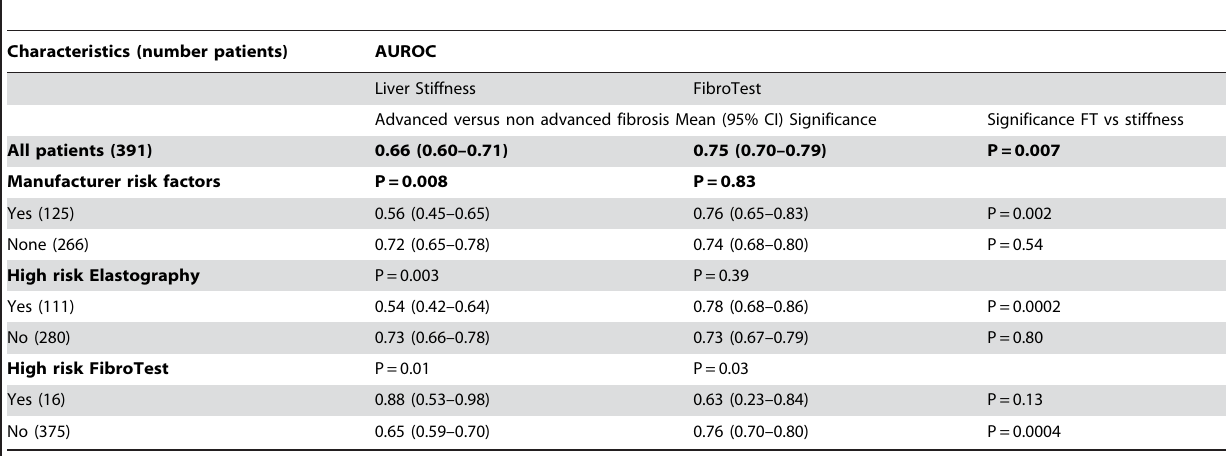
Table 3. Validation of the proof of concept using liver biopsy: manufacturers’ risk factors of false positive/negative are associated with strength of concordance between Elastography and Biopsy.